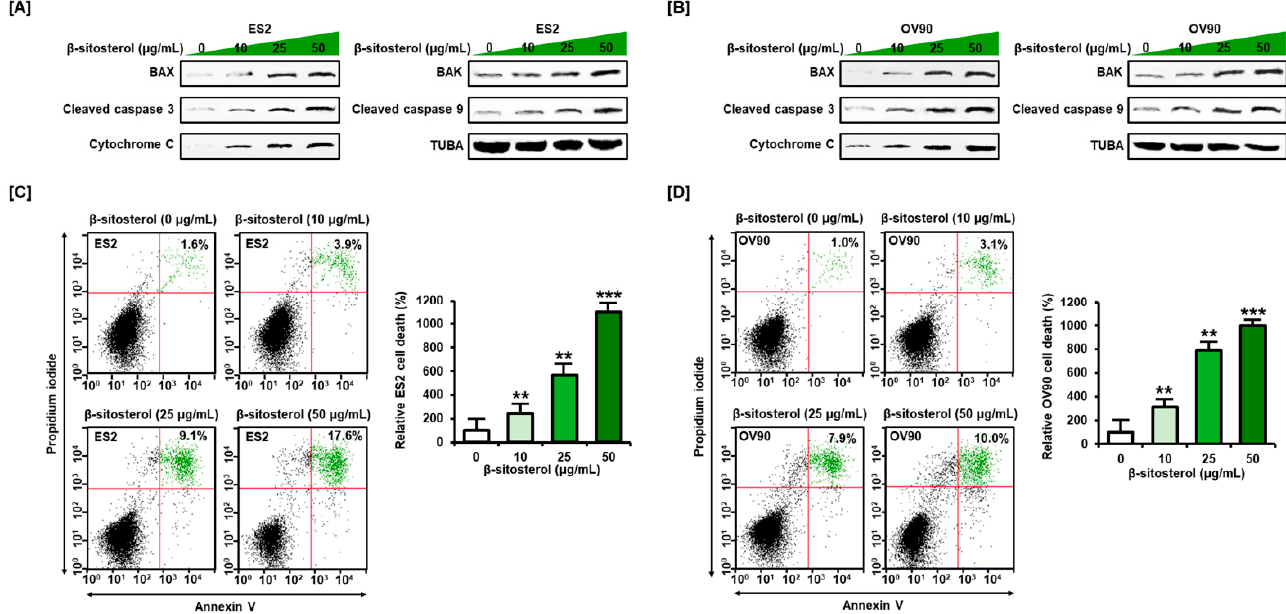
Figure 1. Western blot and annexin V and propidium iodide (PI) staining were performed to investigate cell death in cultures of both cell lines. ( A , B ) Western blot bands showing the expression of pro-apoptotic signal components in β -sitosterol (0, 10, 25, and 50 µg/mL)-treated cells. Alpha-tubulin (TUBA), used as a control, is shown at the bottom right of each figure. ( C , D ) Quadrants of the dot blot represent the state of cell apoptosis in ES2 ( C ) and OV90 ( D ) cells. Comparative bar graphs represent the relative change in late apoptosis following β -sitosterol treatment (0, 10, 25, and 50 µg/mL) com- pared to the control (100%) in ES2 and OV90 cells. The asterisks indicate significant differences between treated and con- trol cells (*** p < 0.001 and ** p < 0.01). 3.2. Changes in Mitochondrial Membrane Potential (MMP) and ROS Levels Caused by β -Sitos- terol in Ovarian Cancer Cells MMP was dramatically changed by treatment with β -sitosterol (0, 10, 25, and 50 µg/mL) in ES2 cells. In ES2 cells, an MMP loss of 240%, 500%, and 740% was observed following treatment with 10, 25, and 50 µg/mL of β -sitosterol, respectively, compared to the vehicle-treated control (100%) (Figure 2A). Similarly, in OV90 cells, an MMP loss of 127%, 204%, and 300% was observed following treatment with 10, 25, and 50 µg/mL of β - sitosterol, respectively, compared to the control (100%) (Figure 2B). ROS production in ES2 cells increased in a dose-dependent manner to 125%, 154%, and 204%, by 10, 25, and 50 µg/mL of β -sitosterol, respectively, compared to the vehicle-treated control (100%) (Fig- ure 2C). ROS generation in OV90 cells also increased to 117%, 162%, and 221%, following treatment with 10, 25, and 50 µg/mL of β -sitosterol, respectively, compared to the control (100%) (Figure 2D). Further, we pre-treated the cells with N-acetylcysteine (NAC) for 1 h before treatment with β -sitosterol to figure out the relationship between β -sitosterol-in- duced mitochondrial dysfunction and ROS generation (Figure 2E). Although there were no alleviation effects of MMP loss on ES2 cells, β -sitosterol-induced MMP loss in OV90 was slightly suppressed by NAC (Figure 2E). These results might imply that β -sitosterol mainly exerted a detrimental effect in mitochondria, and as a result, ROS homeostasis was indirectly disturbed.